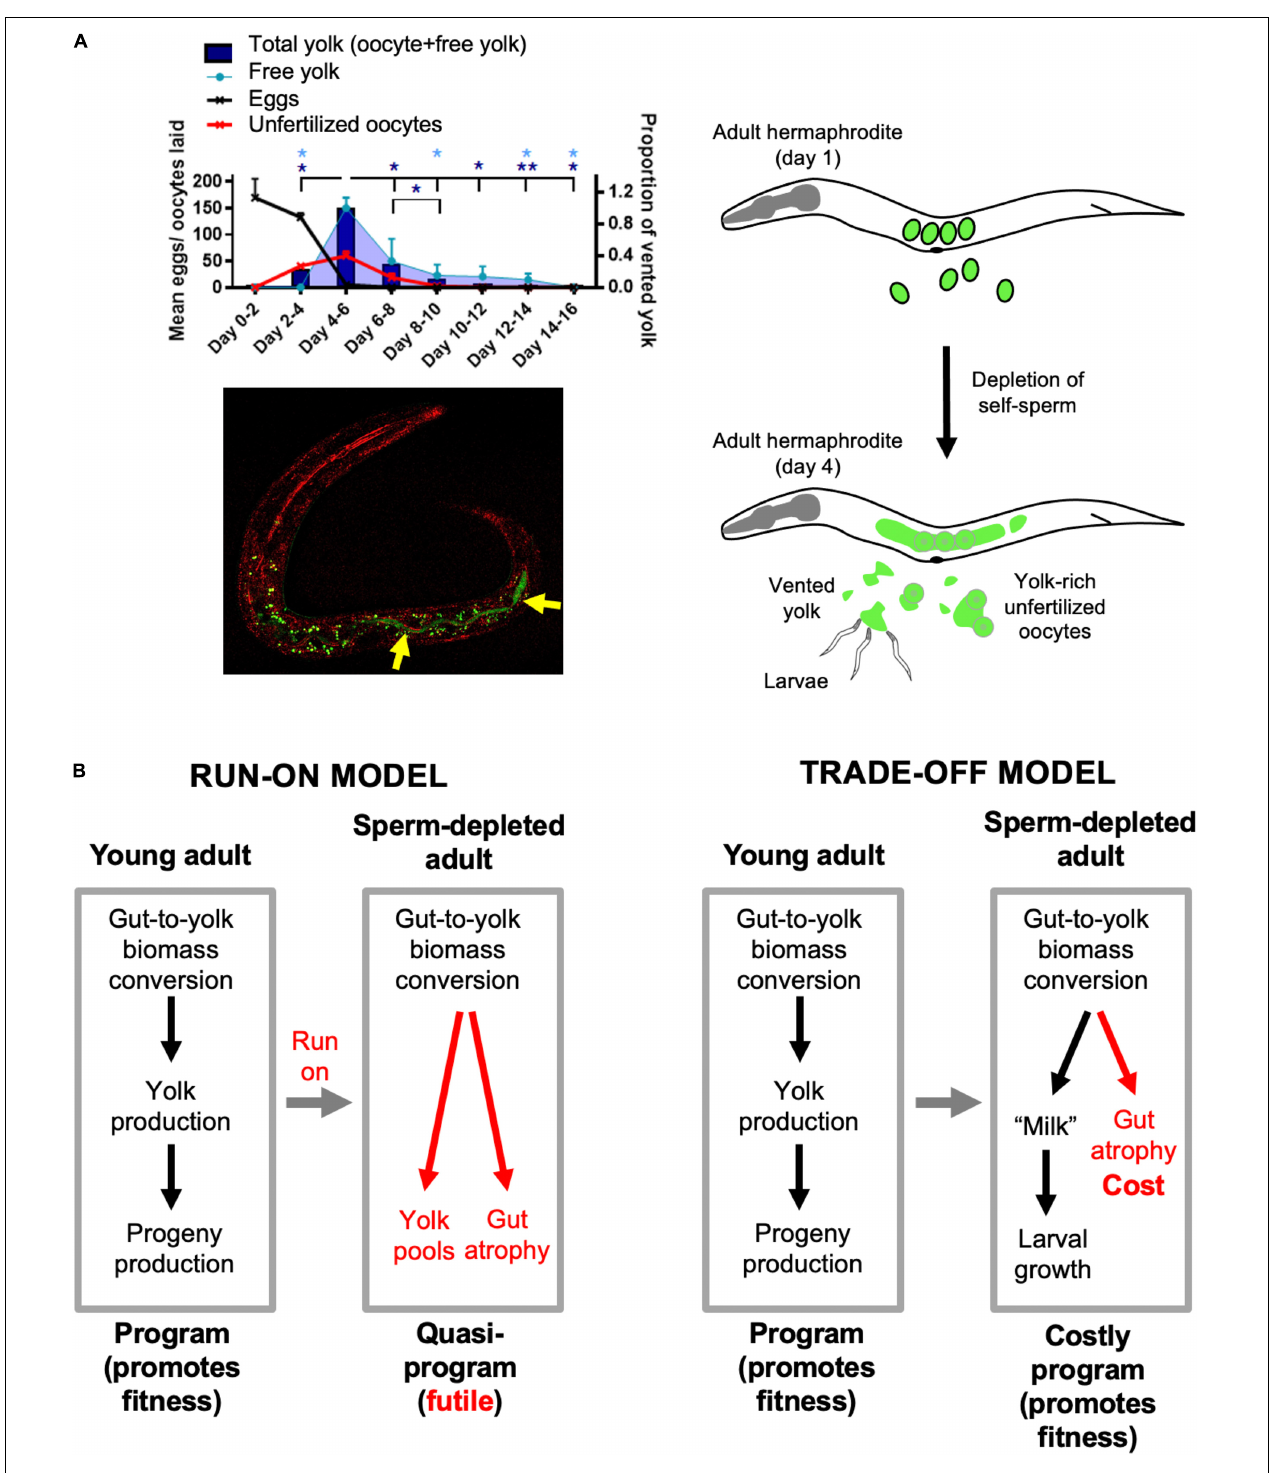
FIGURE 2 | Lactation by C. elegans hermaphrodites, and its implications. (A) Trophallaxis (“milk” provision) by C. elegans . Top left: schedule of production of eggs, unfertilized oocytes and vented yolk by wild-type C. elegans hermaphrodites (20 ◦ C); * p < 0.05, ** p < 0.01, one-way ANOVA. Bottom left: L1 larva with ingested yolk in intestinal lumen (reproduced from Kern et al., 2021). Green: yolk marked with VIT-2:GFP (arrows); green dots are autofluorescent gut granules. Red, reflective confocal microscopy to highlight intestinal lumen (intestinal cell apices). Right: scheme showing transition from egg laying to yolk (milk) venting after hermaphrodite self-sperm depletion. (B) Implications: two interpretations of origins of intestinal atrophy. Left: After sperm depletion the program for yolk synthesis runs on to become a futile quasi-program (Ezcurra et al., 2018). Right: after sperm depletion the program for yolk production becomes a costly program supporting lactation (Kern et al.,